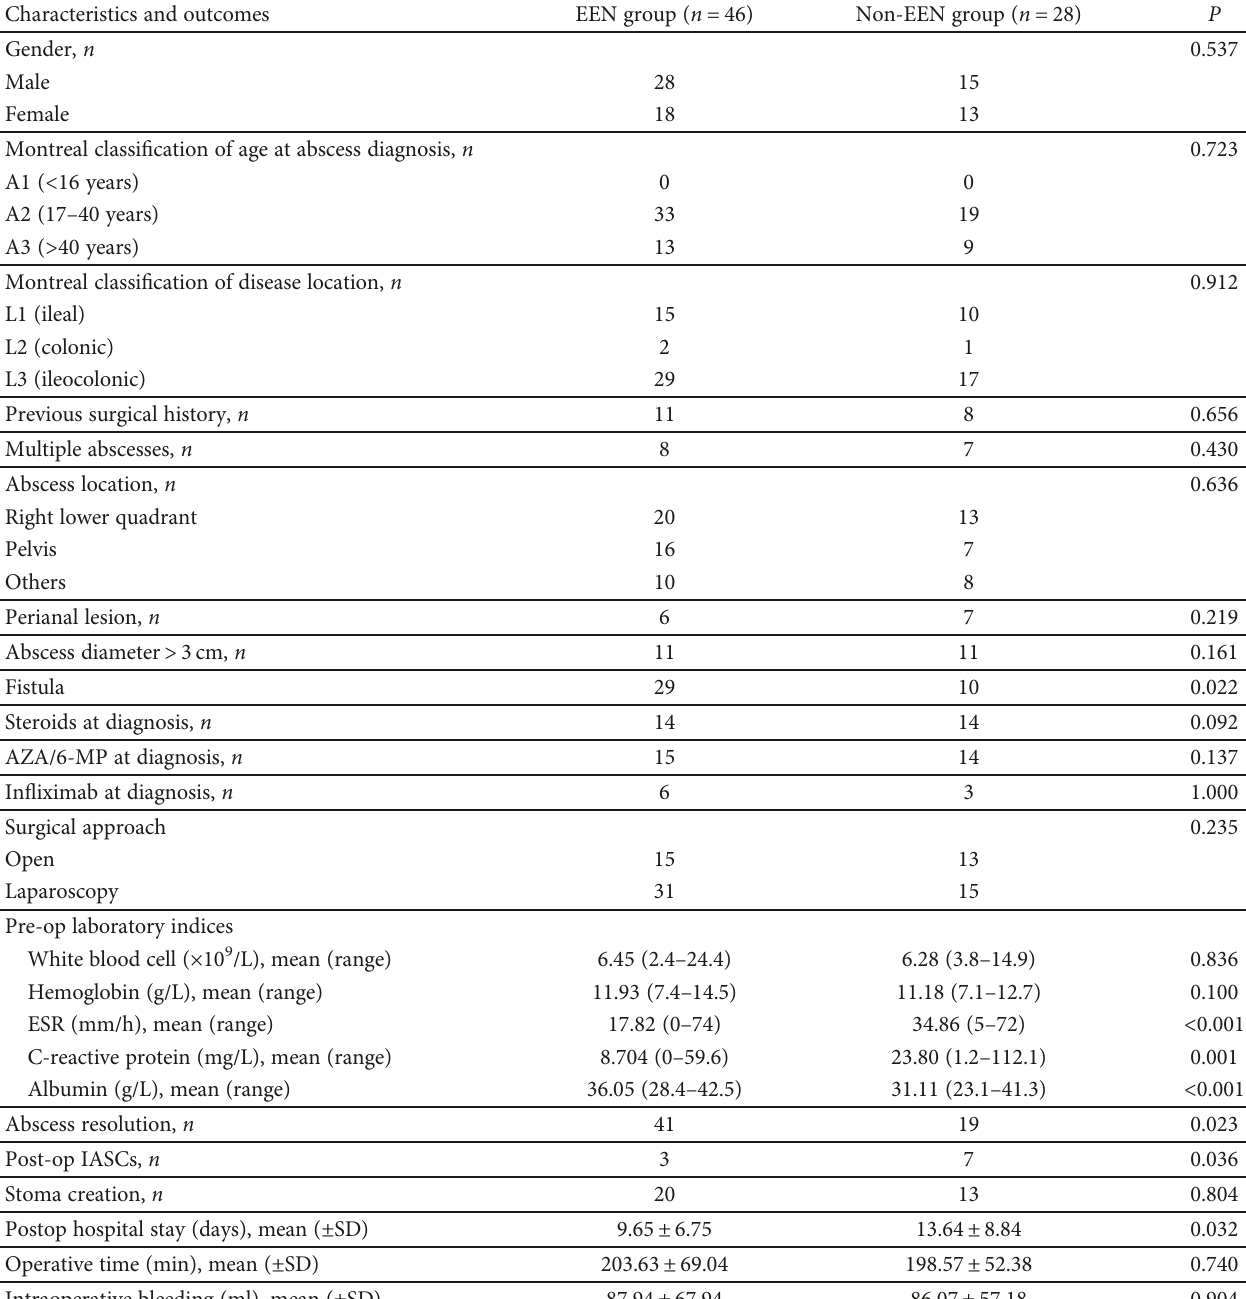
Table 4: Characteristics and postoperative short-term outcomes of patients requiring